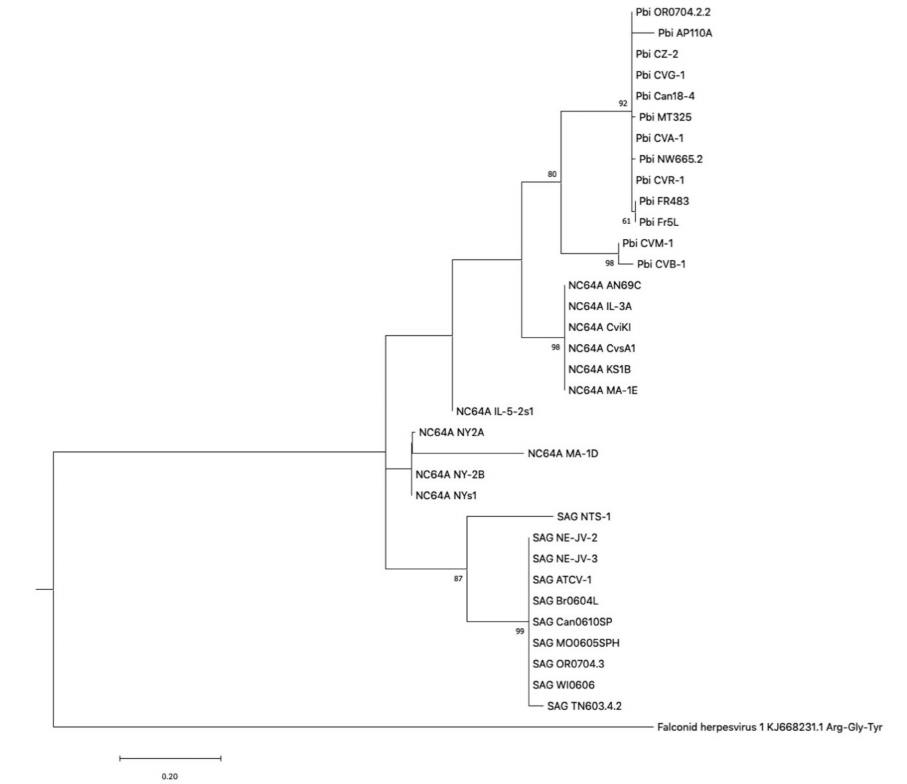
Figure 2. Phylogram of three concatenated tRNA genes—tRNA Gly , tRNA Tyr , and tRNA Arg —using the maximum likelihood tree building algorithm with 100 bootstraps using the online website: